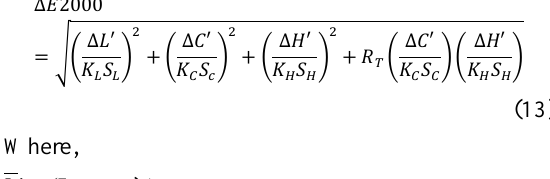
Figure 7. Interaction plot for print density The interaction plot for density (Figure 7) shows higher density at 24s viscosity, 5.3 BCM anilox volume for a circular dot shape at lower substrate opacity. The interaction of viscosity with anilox volume, dot shape and substrate opacity affects the print density. The higher solid content at 24 sec ink viscosity and more ink carrying capacity of 5.3 BCM anilox volume resulted in high ink deposition on to the substrate; thereby higher print density. The higher area coverage of plate dot 1 and higher viscosity of 24 sec with less ink spread yielded in higher ink film thickness, thus higher print density. The ink with higher viscosity, high anilox BCM and circular dots yield high print densities. The interaction plot shows great inter dependence of circular dots with anilox volume. A sharp rise in print density was observed with circular dots at 4.5 BCM anilox volume as compared to square dots. The higher ink transfer at lower substrate opacity with higher surface energy was achieved at 24 sec ink viscosity .